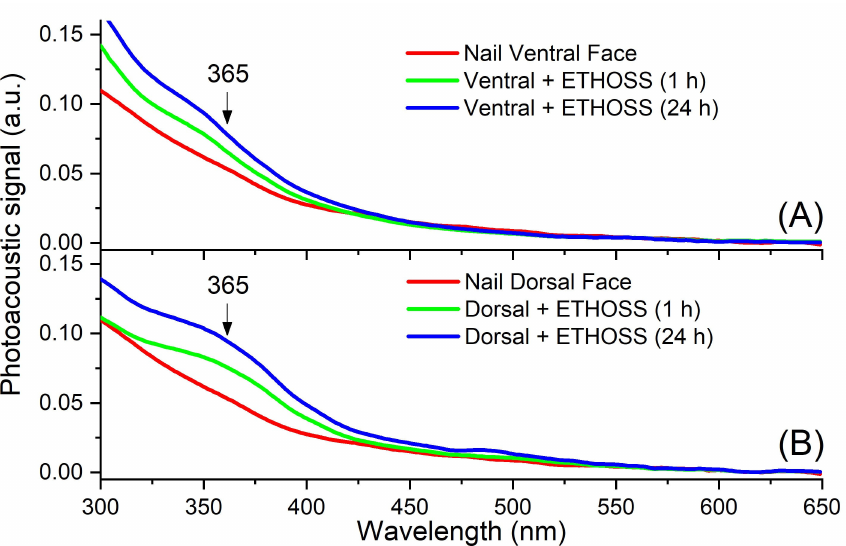
Figure 6. Nail PAS spectra 1 and 24 h after ETHOSS application (100 mg/mL), both on the ventral ( A ) and dorsal ( B ) faces. There was permeation of the extract through the total thickness of the nail, regardless of the face in which it was